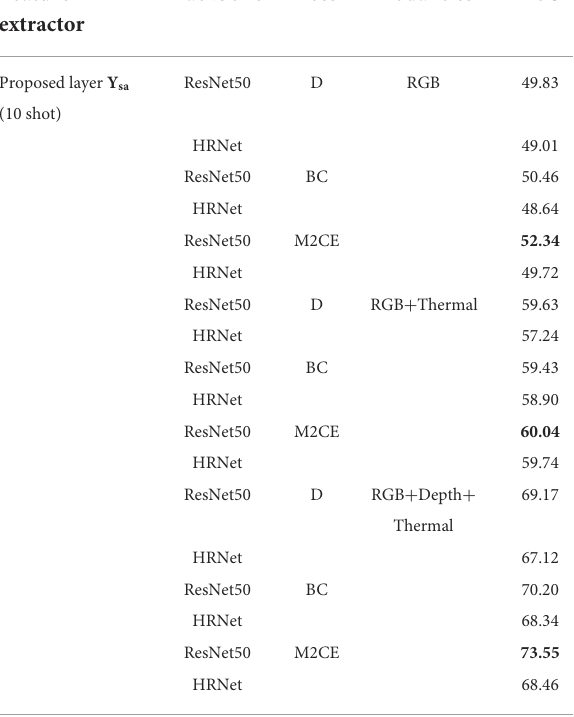
TABLE 3 Ablation study on using different modalities, loss functions, and backbones.